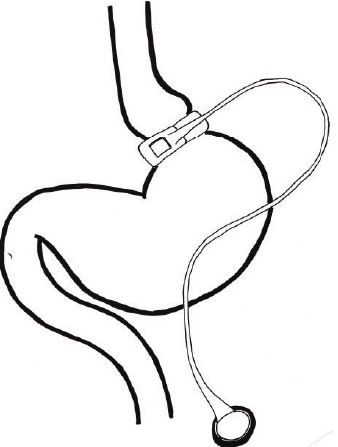
Figure 1. Laparoscopic Adjustable Gastric banding